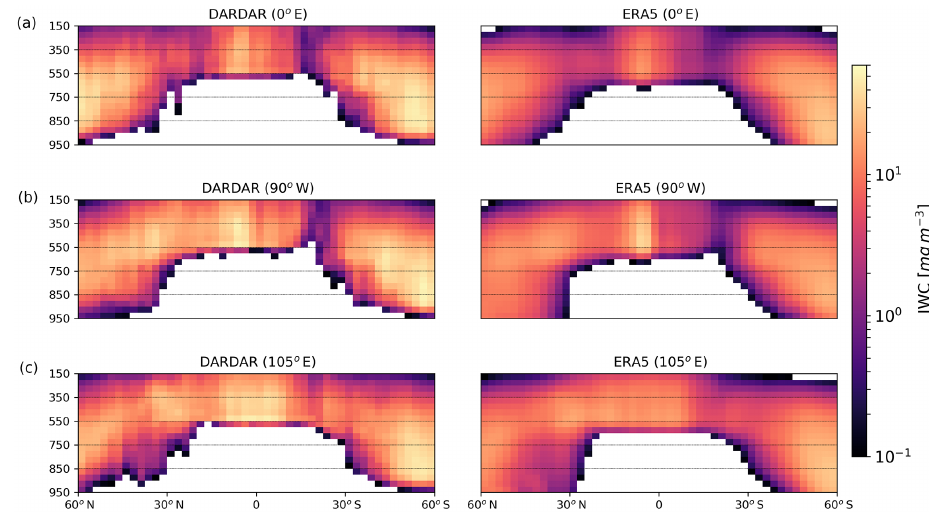
Figure 4. Annual mean IWC profiles through three longitude slices centred at 0 ◦ E (a) , 90 ◦ W (b) , and 105 ◦ E (c) . ERA5 values are a sum of cloud and precipitating ice. Data are limited to daytime in 2015 as before. Values below 0.1mgm − 3 are in white. The y axis is given as pressure levels in units of hPa, a convention that is maintained in Figs. 5 and 6 as well.